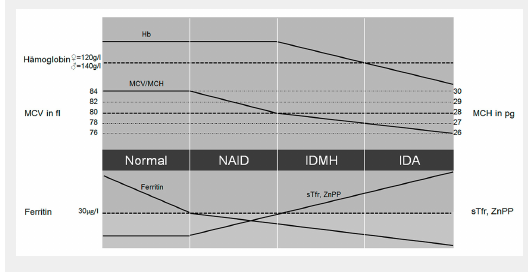
Stages of iron deficiency. Hb = haemoglobin; IDA = iron deficiency anaemia; IDMH = iron deficiency with microcytosis and/or hypochromia; MCH = mean cellular haemoglobin; MCV = mean cellular volume; NAID = nonanaemic iron deficiency; sTfr = soluble transferrin receptor; ZnPP = zinc protoporphyrin